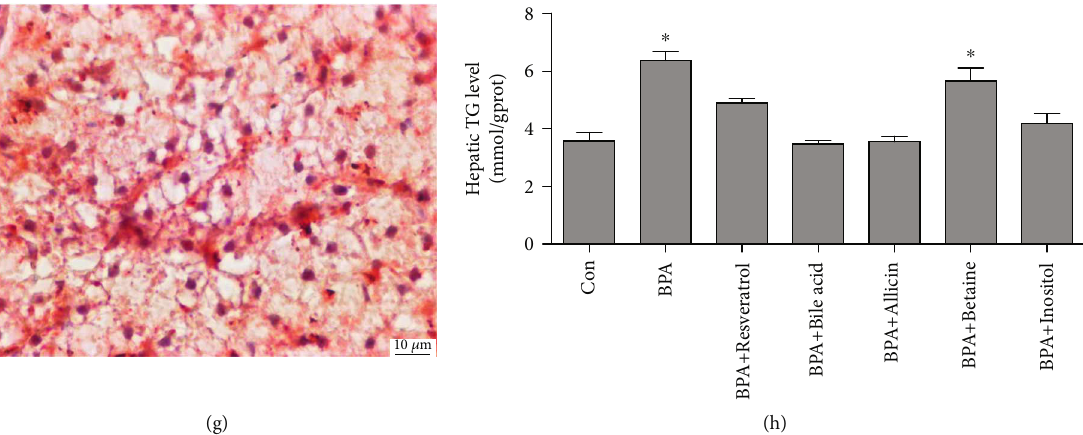
Figure 2: Hepatic oil red O staining and TG levels. (a) Liver from Con group; (b) liver from BPA treatment group; (c) liver from resveratrol group; (d) liver from bile acid group; (e) liver from allicin group; (f) liver from betaine group; (g) liver from inositol group; (h) e ff ect of the experimental additives on rare minnow hepatic TG level. The red part represents lipids. All statistical data were expressed as mean ± SD ( n =3). ∗ stands for there is a signi fi cant di ff erence between the treatment groups and Con groups ( P < 0 : 05